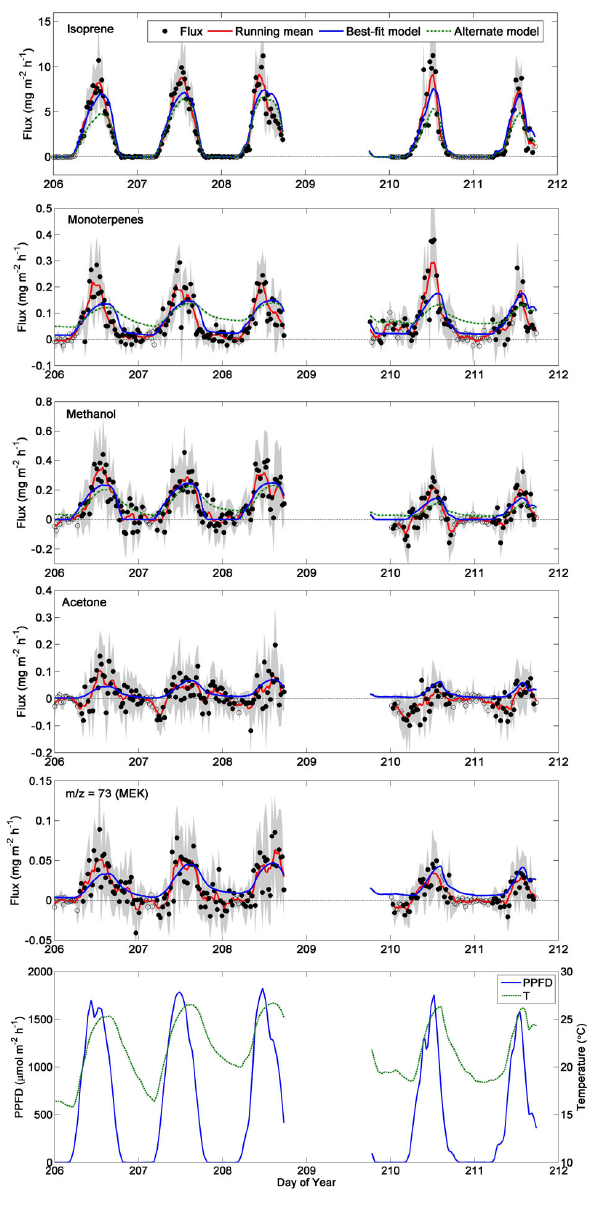
Fig. 3. Fluxes of VOCs computed for half-hour intervals during July, 2007. The grey shaded region is the 2 σ uncertainty range, computed from the covariance at times far away from the true lag as described in the text. Open points indicate time periods of stag- nant air, as determined by values of u ∗ below 0.2m/s. The red line is a 5-point running mean of the flux measurements. The best model fit and an alternate are also shown. The models used are as follows: isoprene – MEGAN algorithm (best), G93 algorithm (alt); monoterpenes – G93 algorithm with Eq. (4) fit to nighttime data (best), Eq. (4) only (alt); methanol – G93 (best); Eq. (4) (alt); ace- tone – Eq. (4) (best); MEK – Eq.. (4) (best). Temperature and PPFD measured during this time period are also